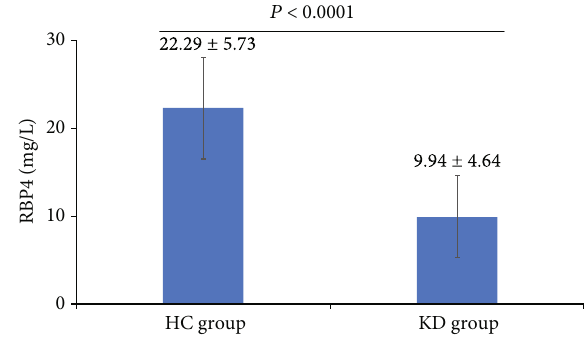
Figure 1: The concentration of serum RBP4 in two groups.